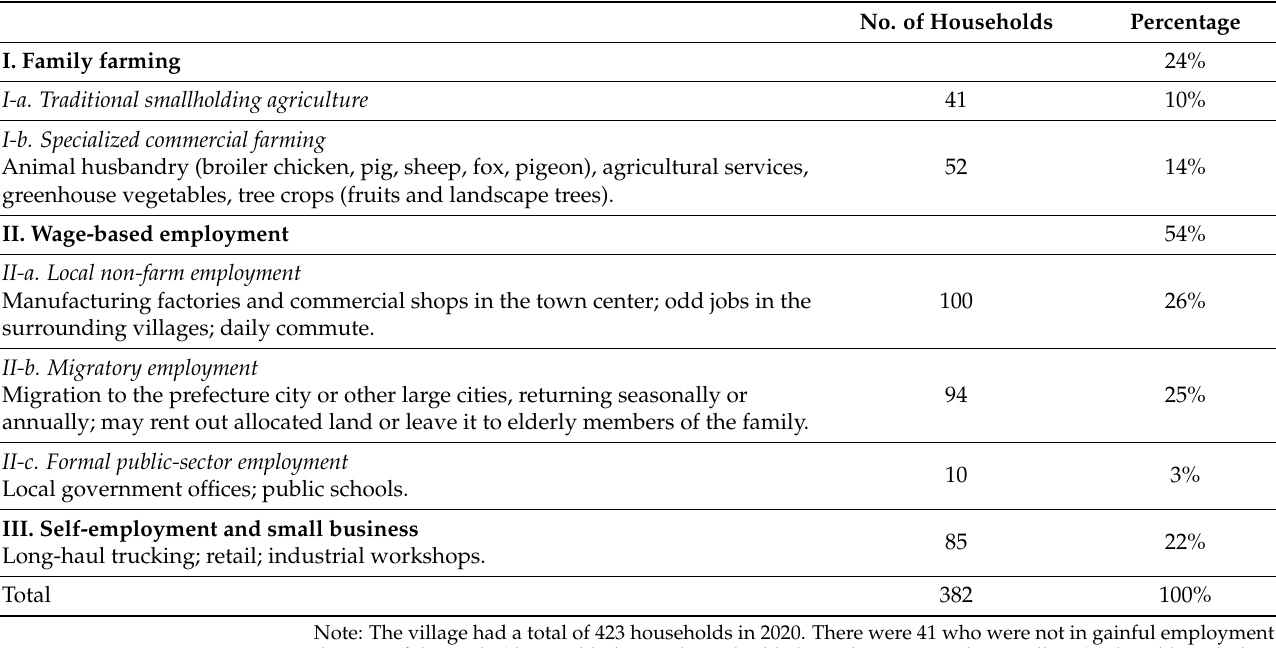
Table 2. Households by employment type in